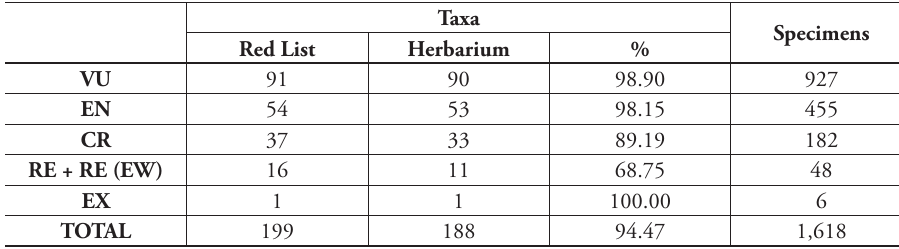
Table 1. Representation of the Catalonian threatened taxa in the dataset.